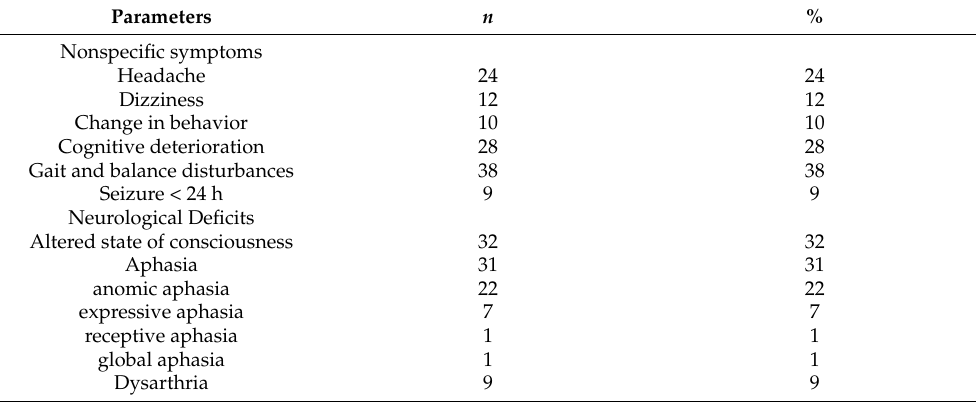
Table 2. Symptoms and neurological deficits in a symptomatic chronic subdural hematoma (cSDH).